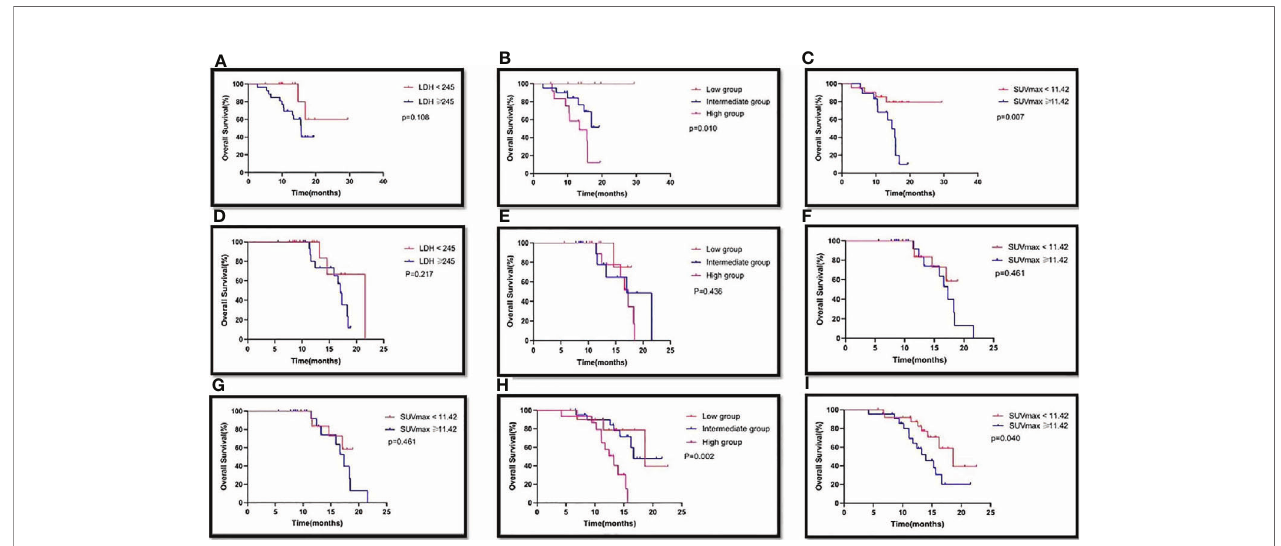
FIGURE 4 | Survival curves of LDH(<245 VS ≥ 245), combination group(Low group, LDH<245 and SUVmax<11.42; intermediate group, LDH<245 or SUVmax<11.42; high group, SUVmax ≥ 11.42 and LDH ≥ 245) and SUVmax(<11.42 vs ≥ 11.42) of primary tumor in PD-L1 expression <1% (A,B,C) , PD-L1 expression ≥ 1% (D,E,F) and PD-L1 expression not available (G,H,I) with advanced lung cancer, respectively.